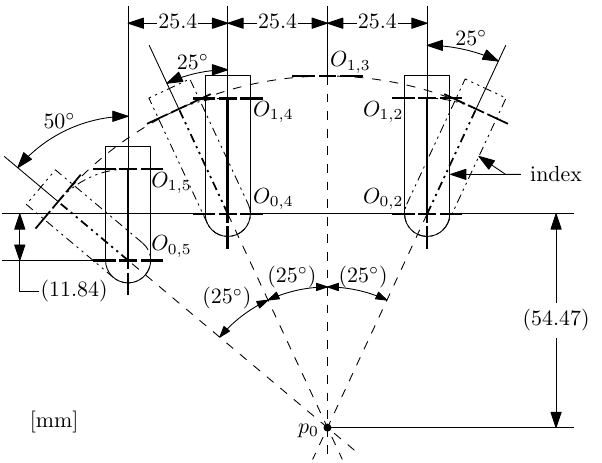
Figure 1. Abduction movement of the metacarpals.